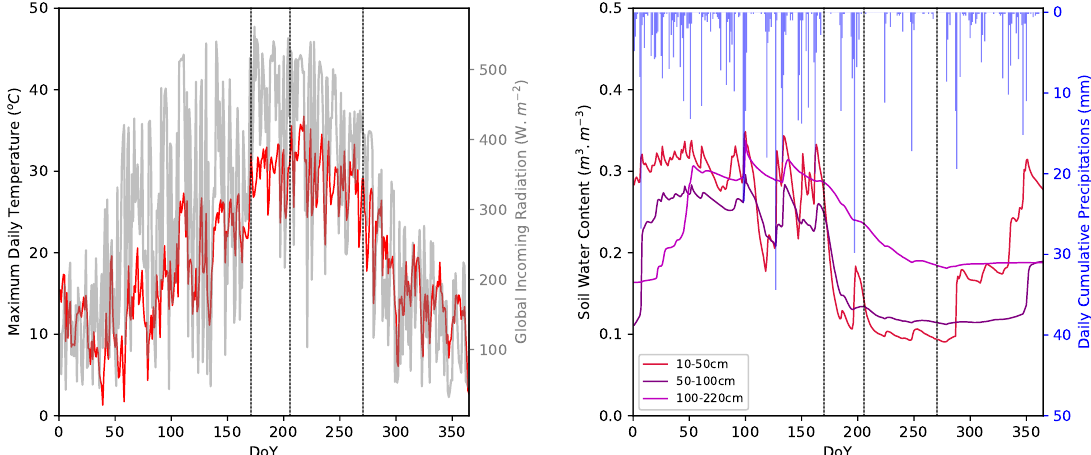
Figure 10. Daily meteorological variables measured at the Centre National de Recherches Meteorologiques (CNRM) de Toulouse: left ) maximum air temperature (red) and global incoming radiation (gray), right ) soil water content at three depth levels (red, purple and pink) and precipitations (blue). Black dashed vertical lines indicate DoY 170, 205 and 270 corresponding to the start dates of the two intra-annual phenological disturbance periods and the end of the second one